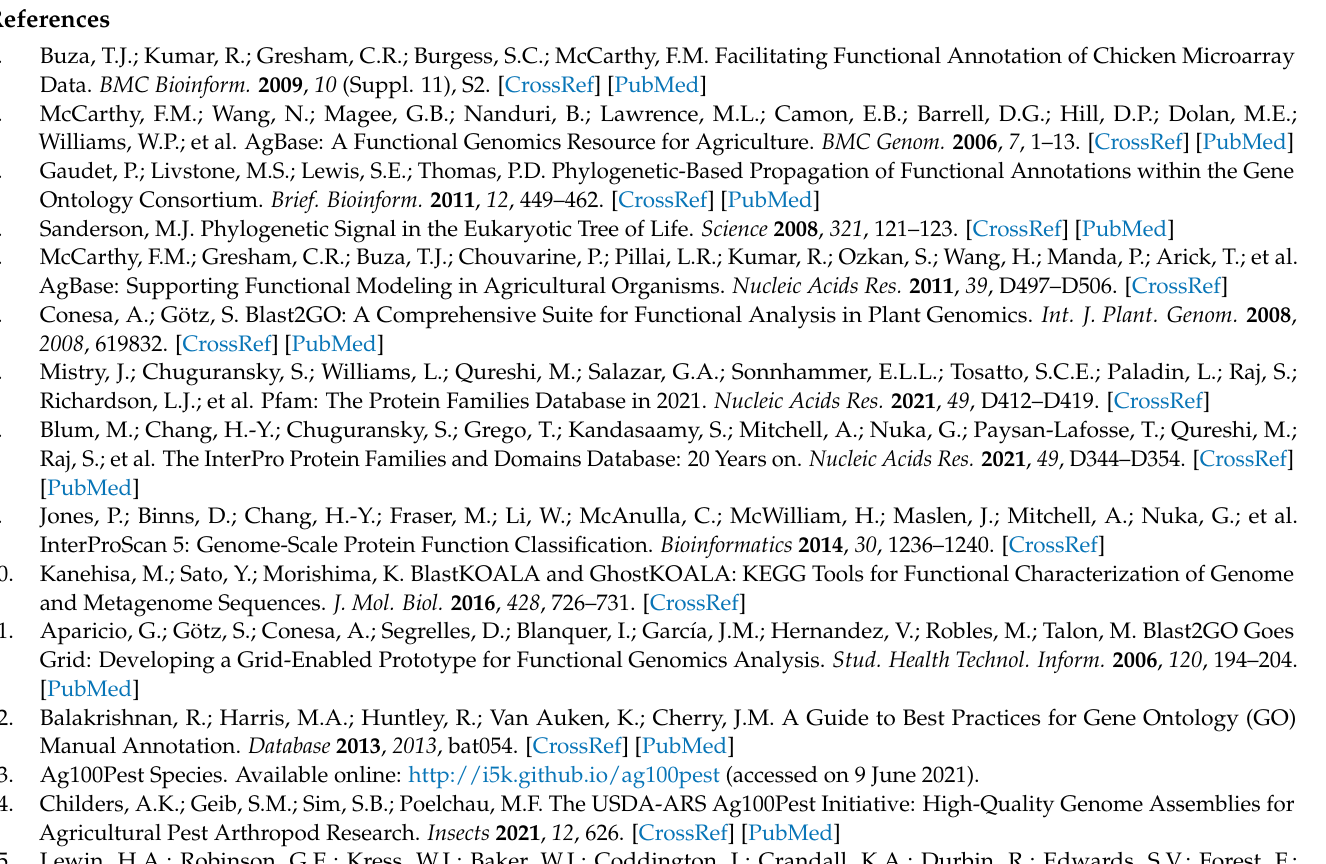
Table S3. KOBAS version 3.0.3 parameters. The parameters are categorized into required and optional. The parameters recommended for optimization are denoted with an